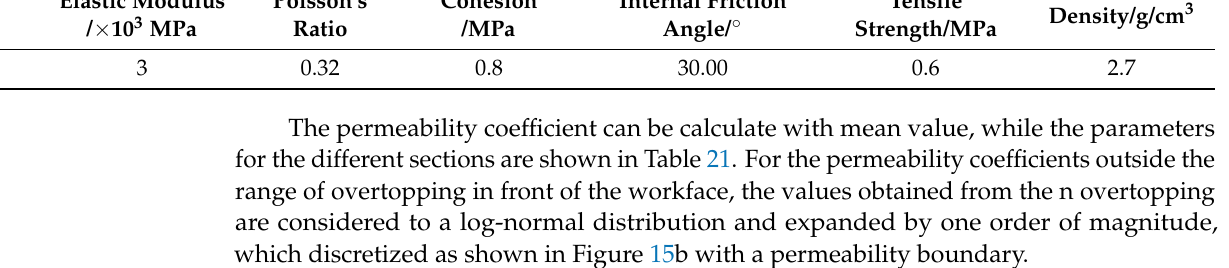
Figure 14. Calculation model diagram. ( a ) Model size drawing, ( b ) Area of random distribution of permeability coefficients outside of grouting.